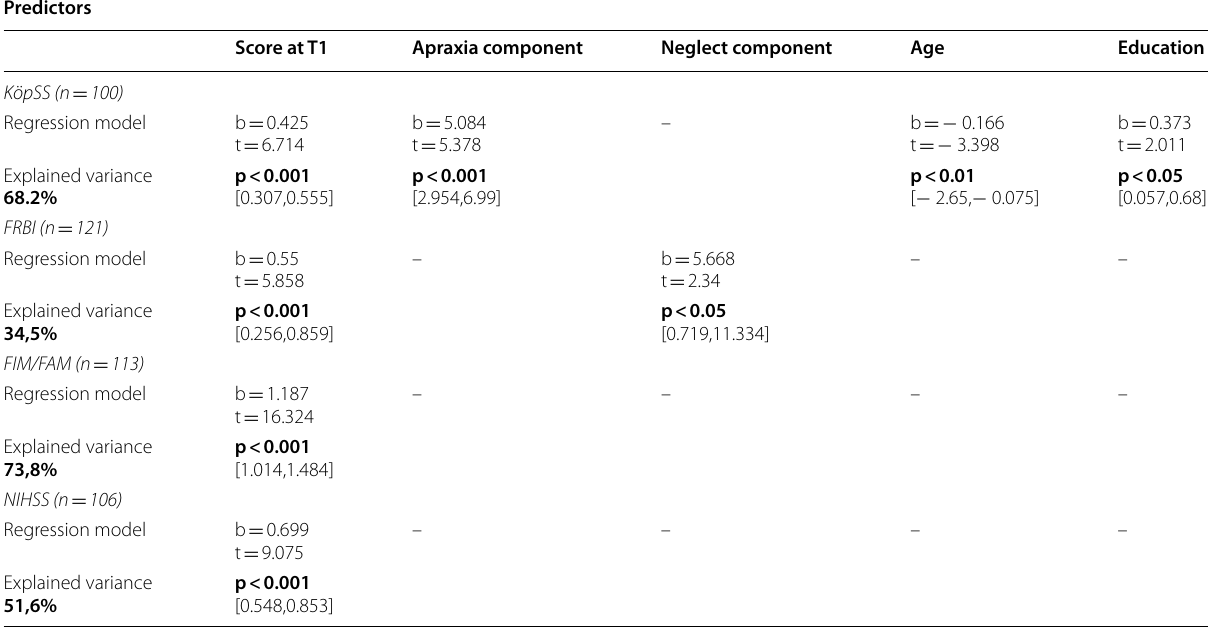
Table 4 Explained variance and regression model characteristics of the multiple regression